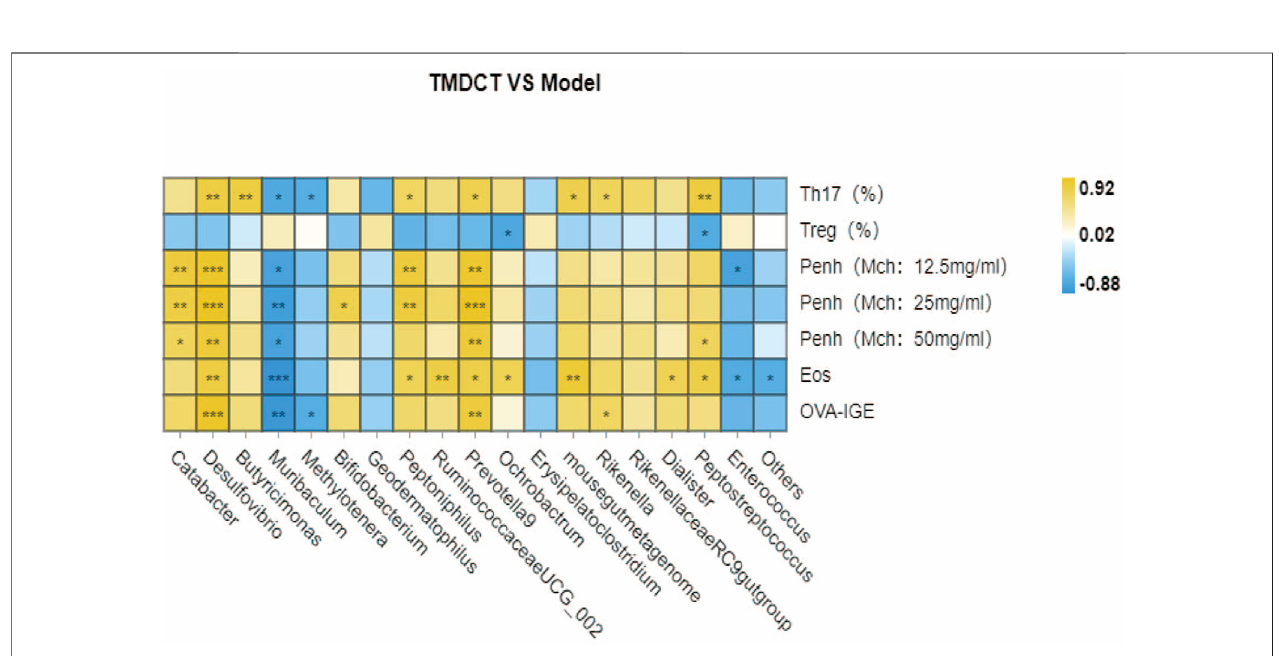
FIGURE 6 | Biomarker selection of gut microbiota associated with Treg/Th17 balance. Correlation of differentiated microbial phylotypes and speci fi c OVA-IgE, Penh value (Mch:12.5, 25, 50 mg/ml), Eosinophil number in BALF, Treg and Th17 cells percentage. * p < 0.05, ** p < 0.01, *** p < 0.001.